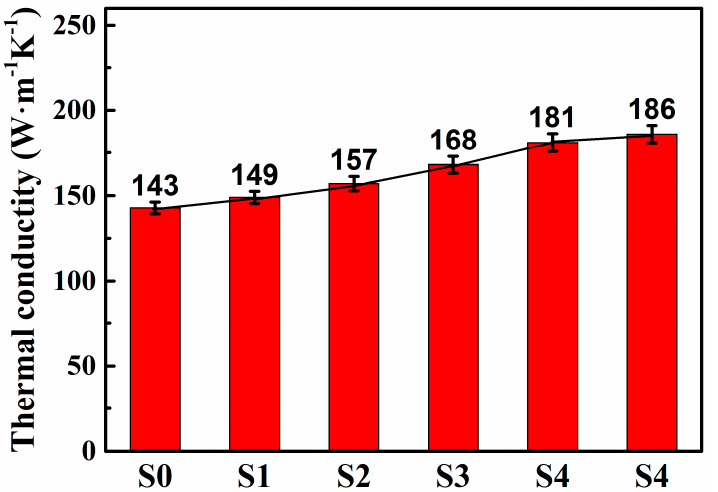
Figure 11. The thermal conductivity of AlN ceramics prepared based on modified AlN powder which has been stored for 1 Year.